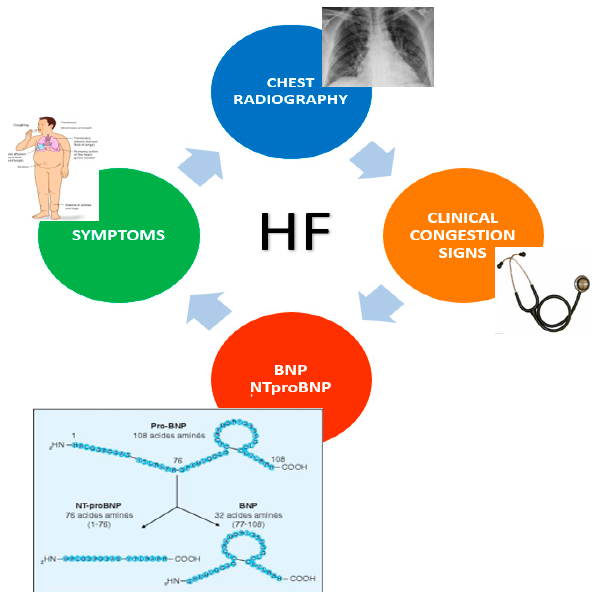
Figure 1. Traditional diagnostic screening for congestion detection in HF: current criteria are based on signs and symptoms, NPs measurement, and chest radiography.